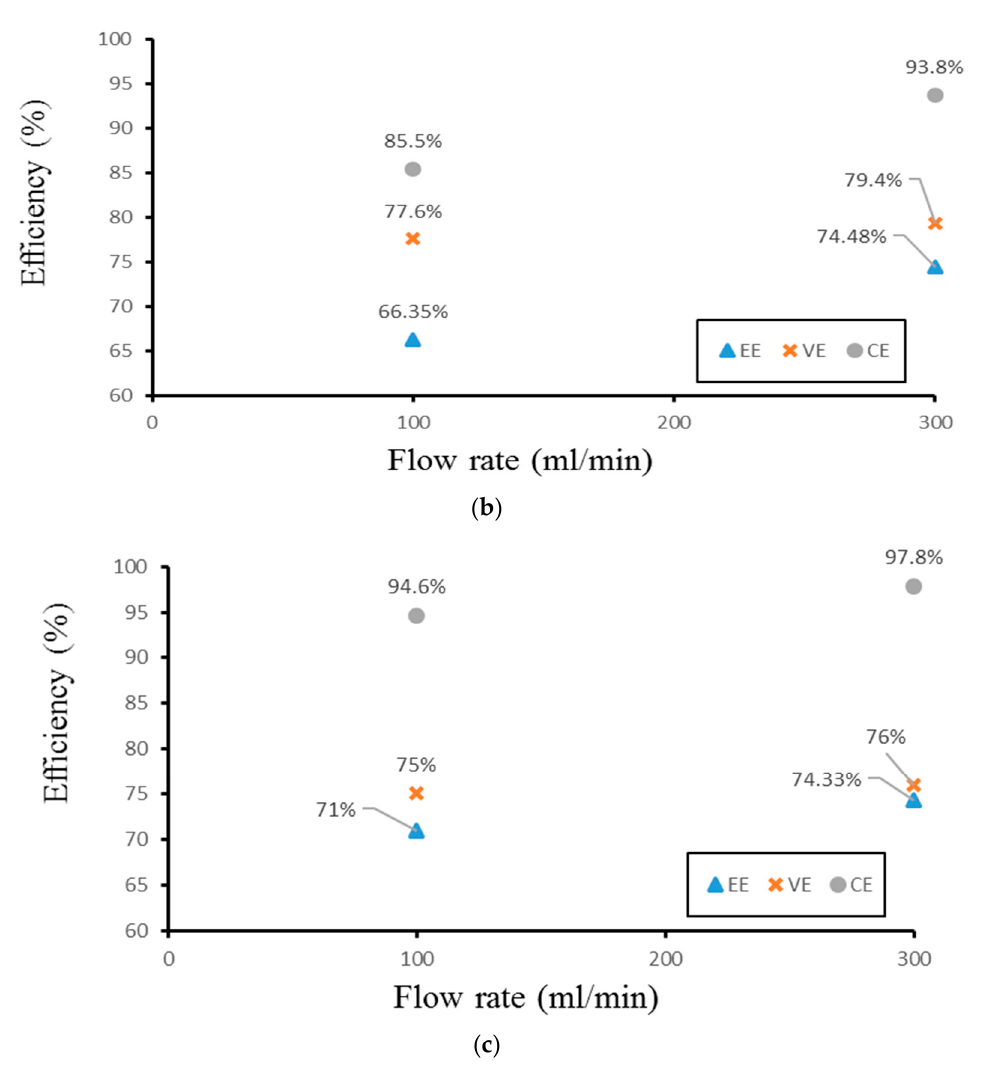
Figure 14. Efficiencies between flow rates of the smooth channel at ( a ) 40 mA/cm 2 , ( b ) 60 mA/cm 2 , and ( c ) 70 mA/cm 2 from the experiment.